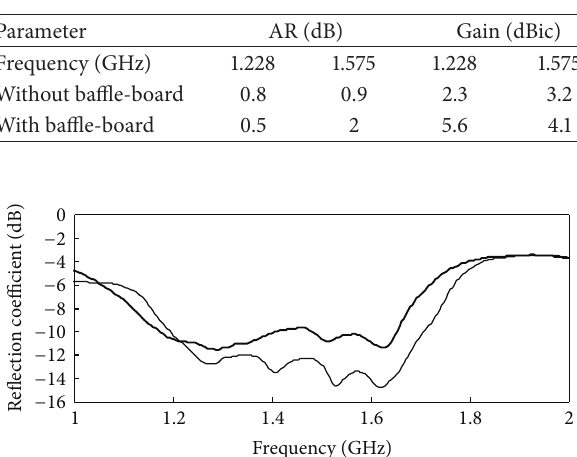
Table 4: Comparison of measured results of axial ratio and gain.